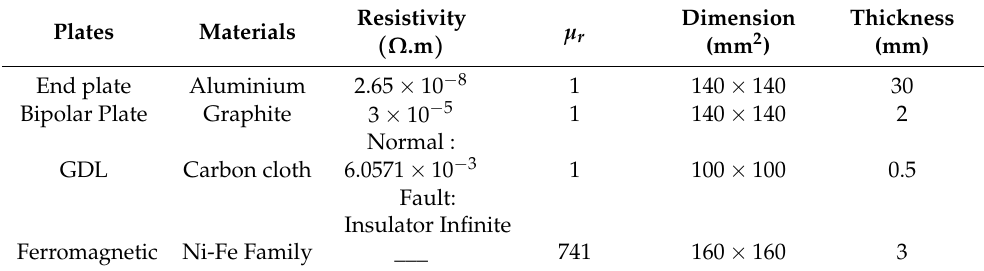
Table 2. Features of the FC stack emulator and ferromagnetic analyzer.